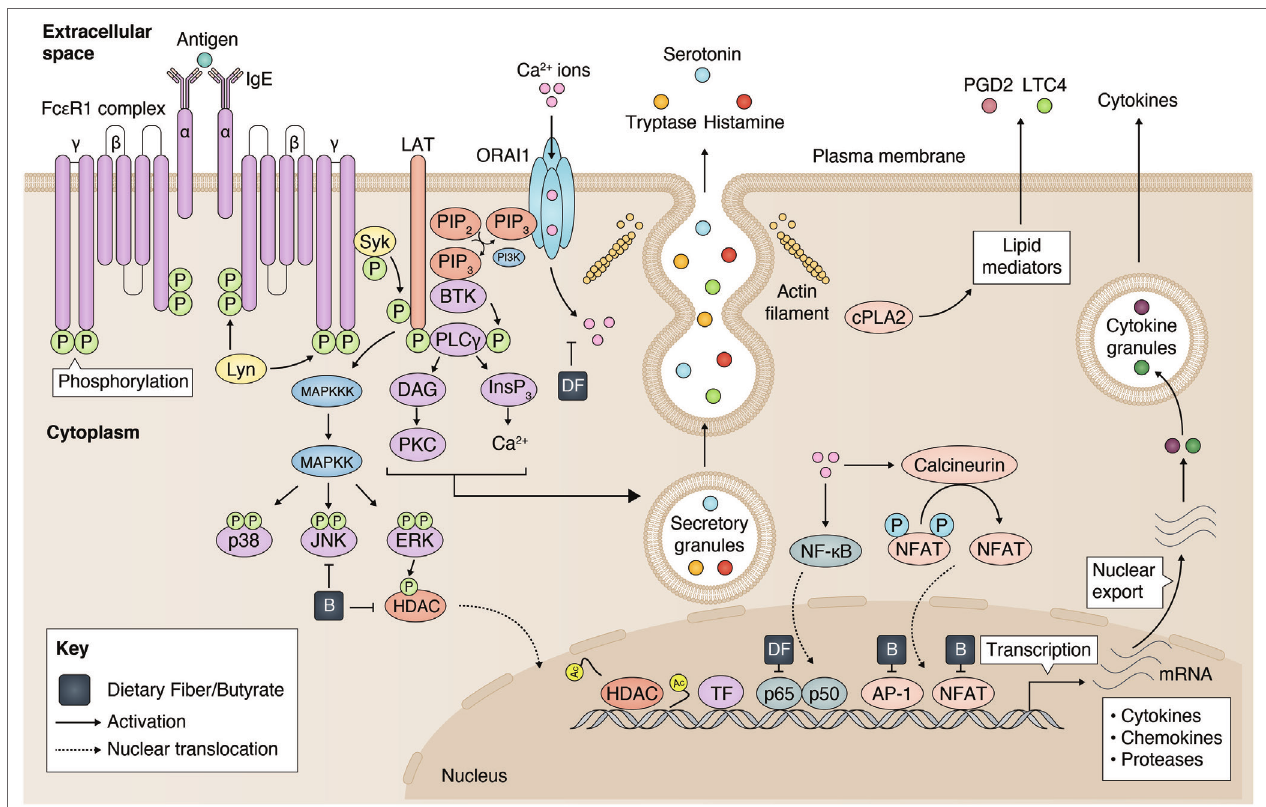
FiGURe 1 | Inhibition of mast cell activation by dietary fiber and butyrate. Mast cell activation is modulated by dietary fiber and butyrate via (1) a reduced calcium entry, (2) inhibition on JKN/p38 phosphorylation, (3) reduced histone deacetylase (HDAC) activity, and (4) regulation of p65, AP-1, NFAT activity. Partly adopted from Cildir et al.